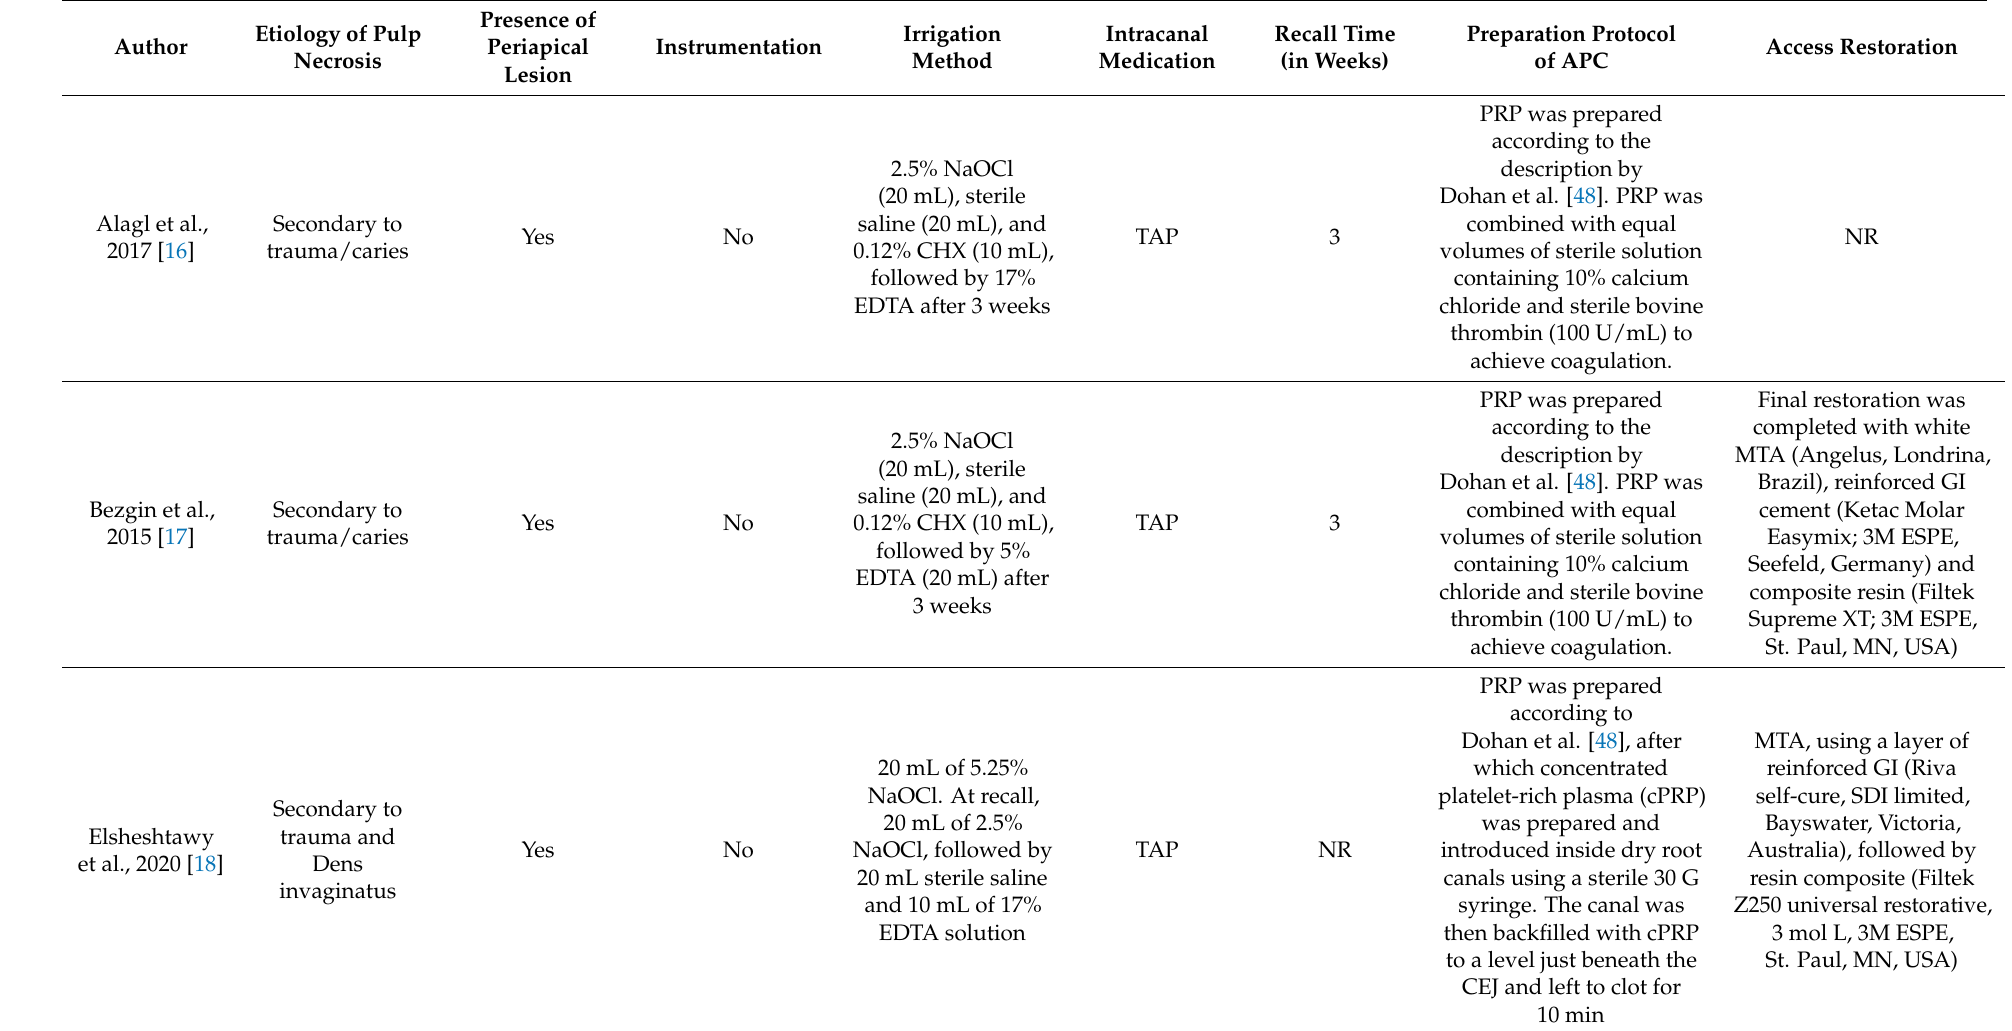
Table 3. Data extraction from included studies – the clinical